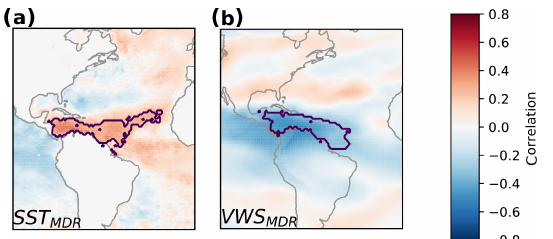
Figure 2. Favourable conditions for high ACE in July–October. (a) Point correlation between SST and basin-wide mean ACE in July–October. The contour line indicates the identified region in the Atlantic basin, which consists of a cluster of the 5% most signifi- cantly correlated grid cells. Details on the definition of the region are described in the Supplement. (b) As panel (a) but for